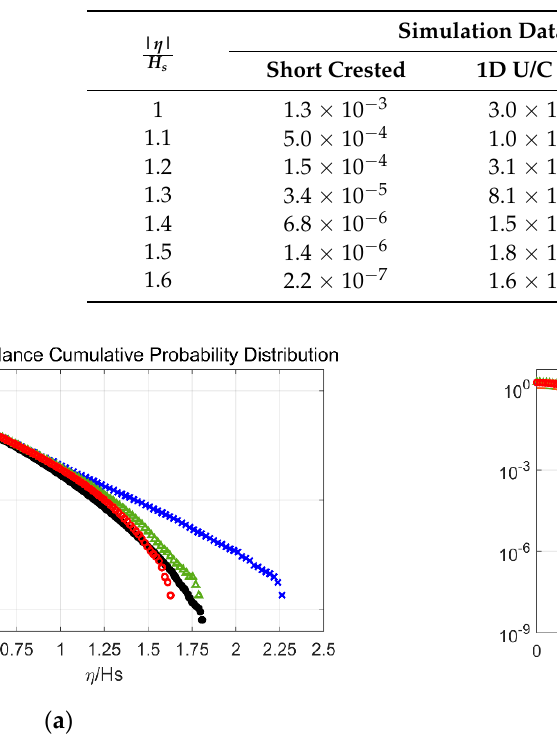
< 1.5 , the probability of the 1D long- H s = 1.6 the probability of H s